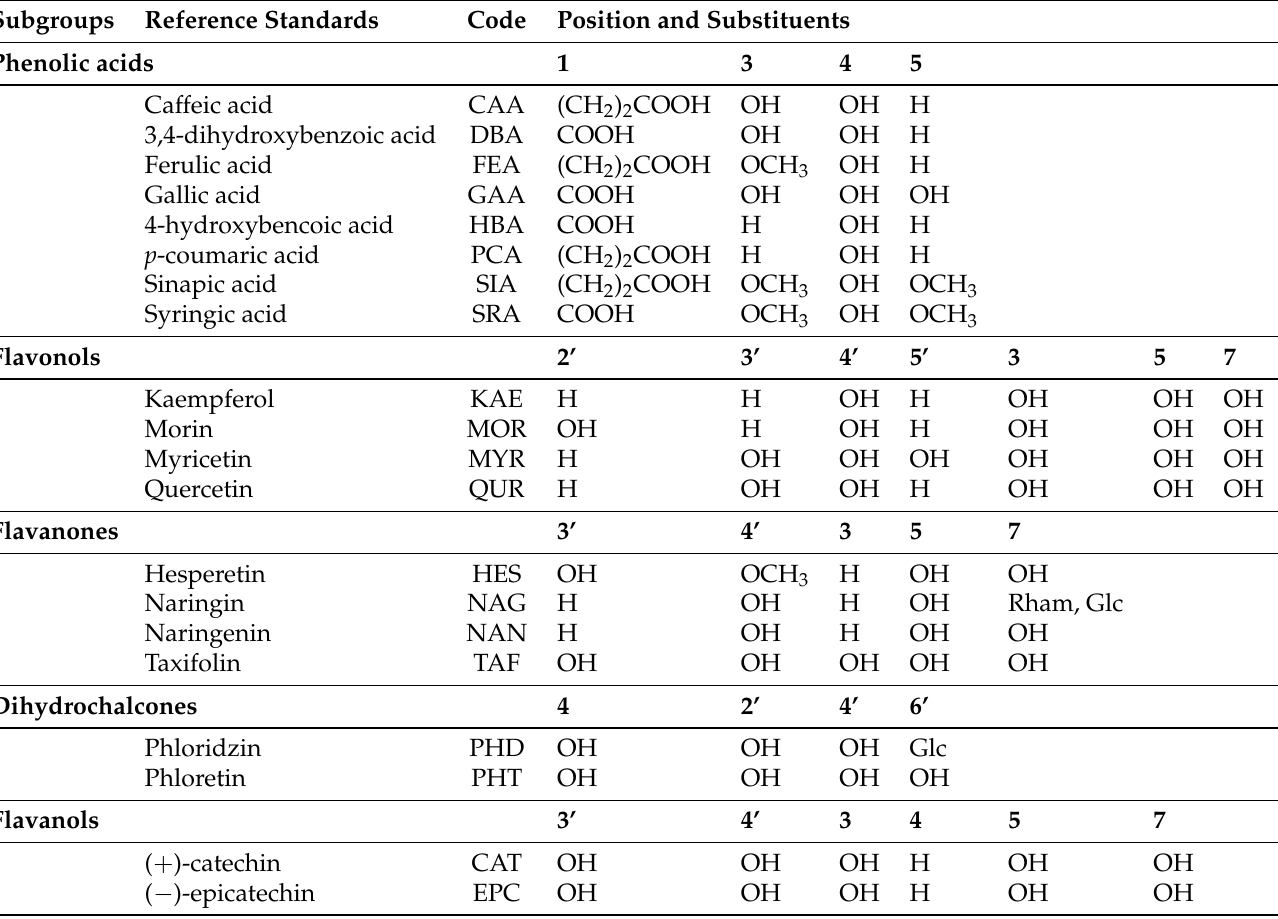
Table 1. Phenolic compounds analyzed in this study (phenolic acids and subgroups of flavonoids) along with reference standard names, sample codes and substituents (adapted with permission from Table 1 in